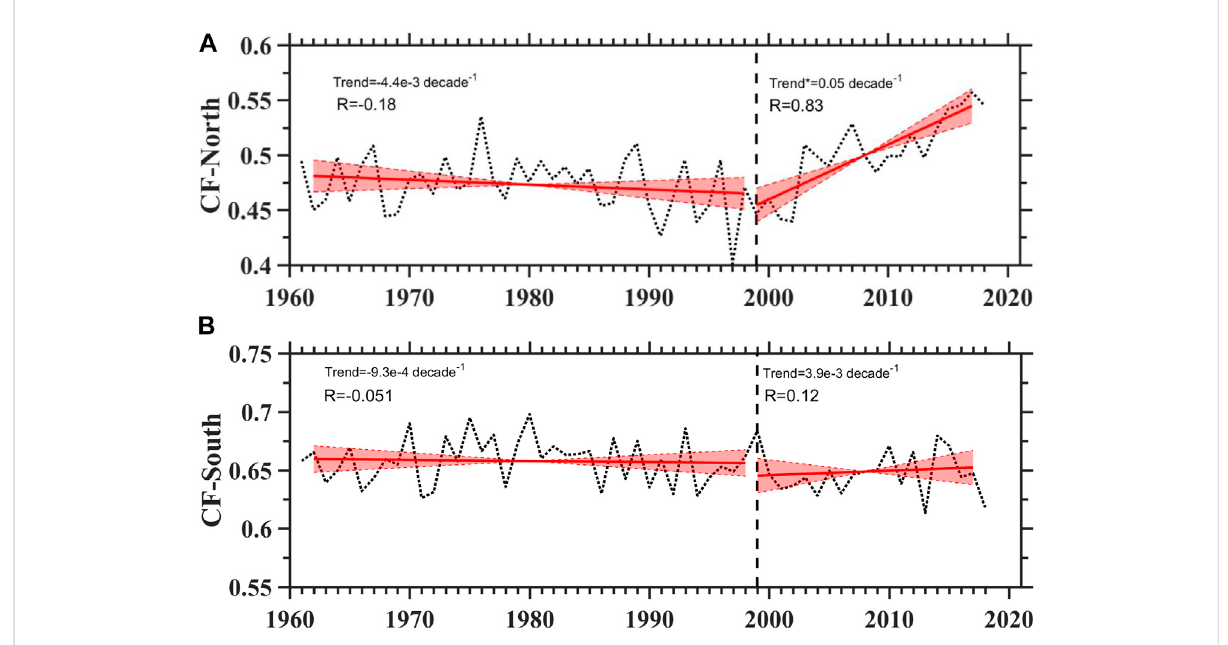
FIGURE 8 Time series of annual Cloud Fraction from the observations in NR in summer [34 ° N-42 ° N,100 ° E-123 ° E] (A) and in SR in summer half-year [19 ° N- 33 ° N, 100 ° E-123 ° E] (B) during the period 1960 – 2018.